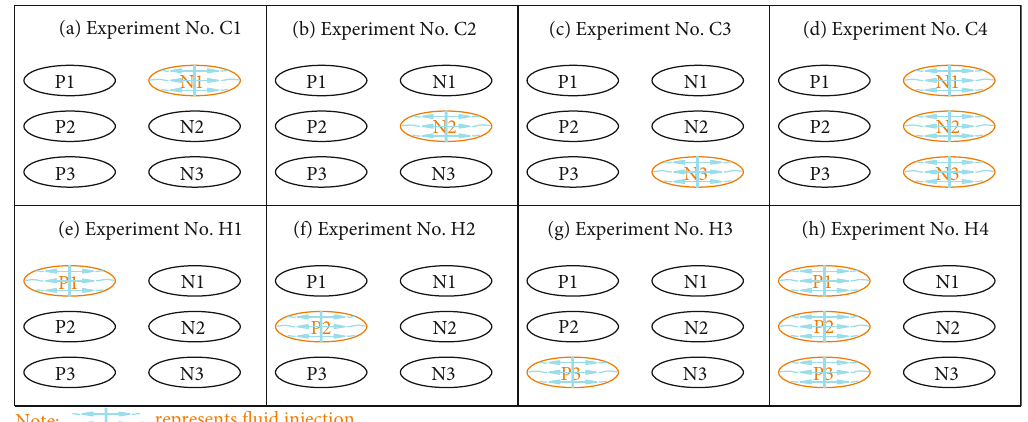
Figure 8: Schematic of numerical experiments according to di ff erent fracturing regions (experiments Nos. C1-C4 and Nos. H1-H4).